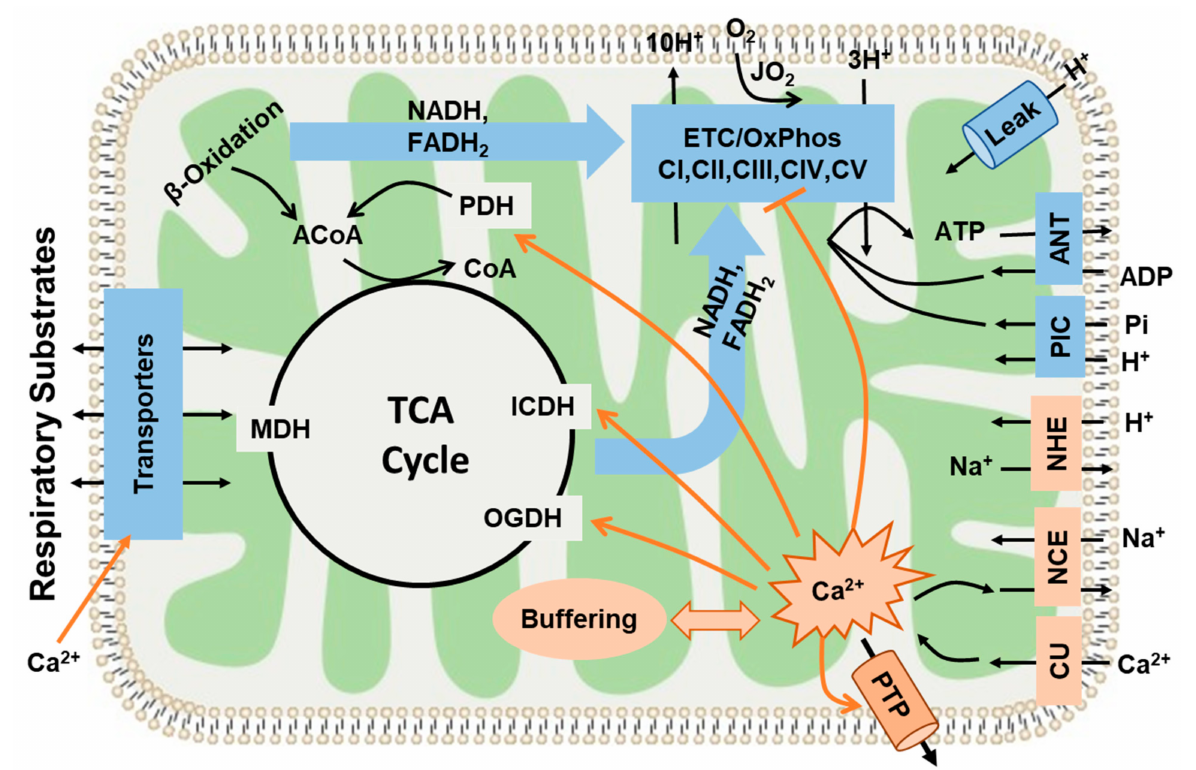
Figure 10. This diagram shows the major pathways and processes regulating mitochondrial bioen- ergetics and Ca 2+ homeostasis. It includes mitochondrial substrate transport and oxidation; tricar- boxylic acid (TCA) cycle; electron transport chain (ETC), H + pumping, and oxidative phosphorylation (OxPhos); inorganic phosphate carrier (PIC: Pi − -H + cotransporter); adenine nucleotide translocase (ANT: ATP-ADP exchanger); and H + leak. It also includes the pathways of mitochondrial Ca 2+ uptake, release, and buffering regulating mitochondrial Ca 2+ homeostasis (CU: Ca 2+ uniporter, NCE: Na + /Ca 2+ exchanger, and NHE: Na + /H + exchanger). The diagram also shows the hypothetical regulatory (activation or inhibition) sites of Ca 2+ on mitochondria OxPhos and ATP synthesis. Ca 2+ activates mitochondrial dehydrogenase enzymes (PDH: pyruvate dehydrogenase, ICDH: isocitrate dehydrogenase, and OGDH: oxoglutarate dehydrogenase) at low concentrations. However, high concentrations of Ca 2+ can inhibit mitochondrial complex I and can result in the opening of a mito- chondrial permeability transition pore (PTP), leading to mitochondrial